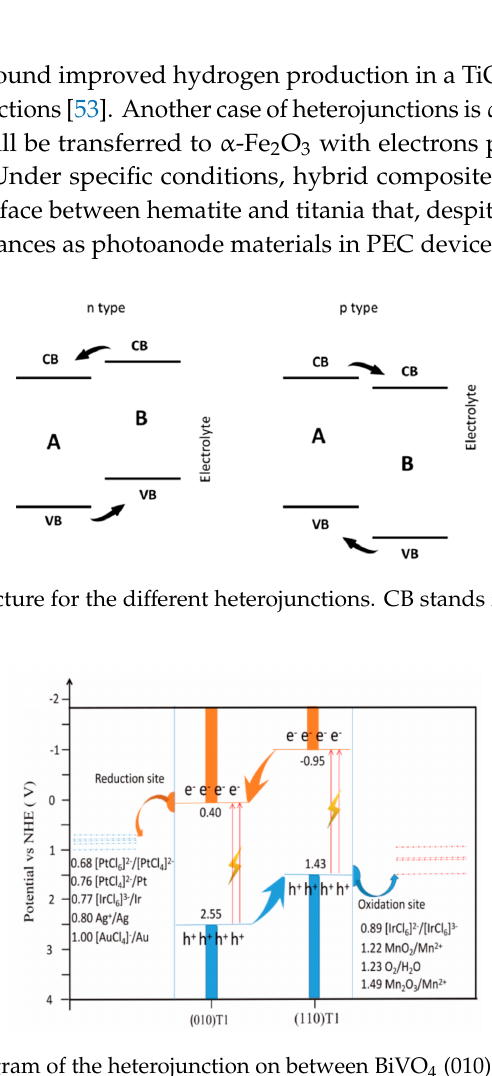
Figure 16. Schematic diagram of the heterojunction on between BiVO 4 (010) and BiVO 4 (110) surfaces. Reprinted with permission from ref. [52]. Copyright 2018. American Chemical Society.